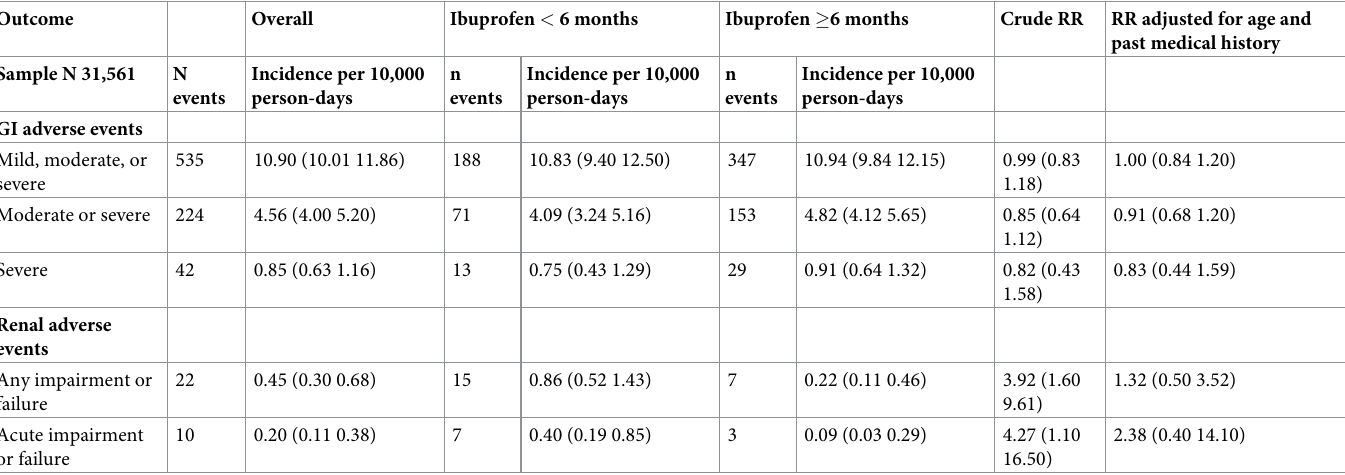
Table 4. Hypothesis 1 at 14-day follow